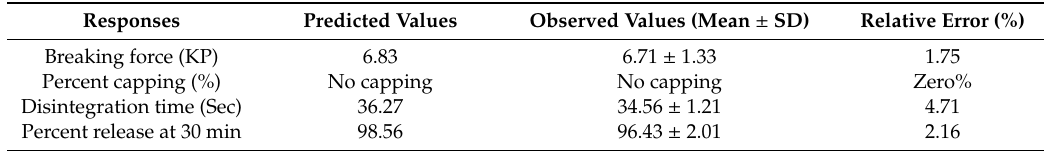
Table 11. Predicted and observed values for all dependent responses of optimized formulation with their relative errors, overall desirability = 0.968 (close to